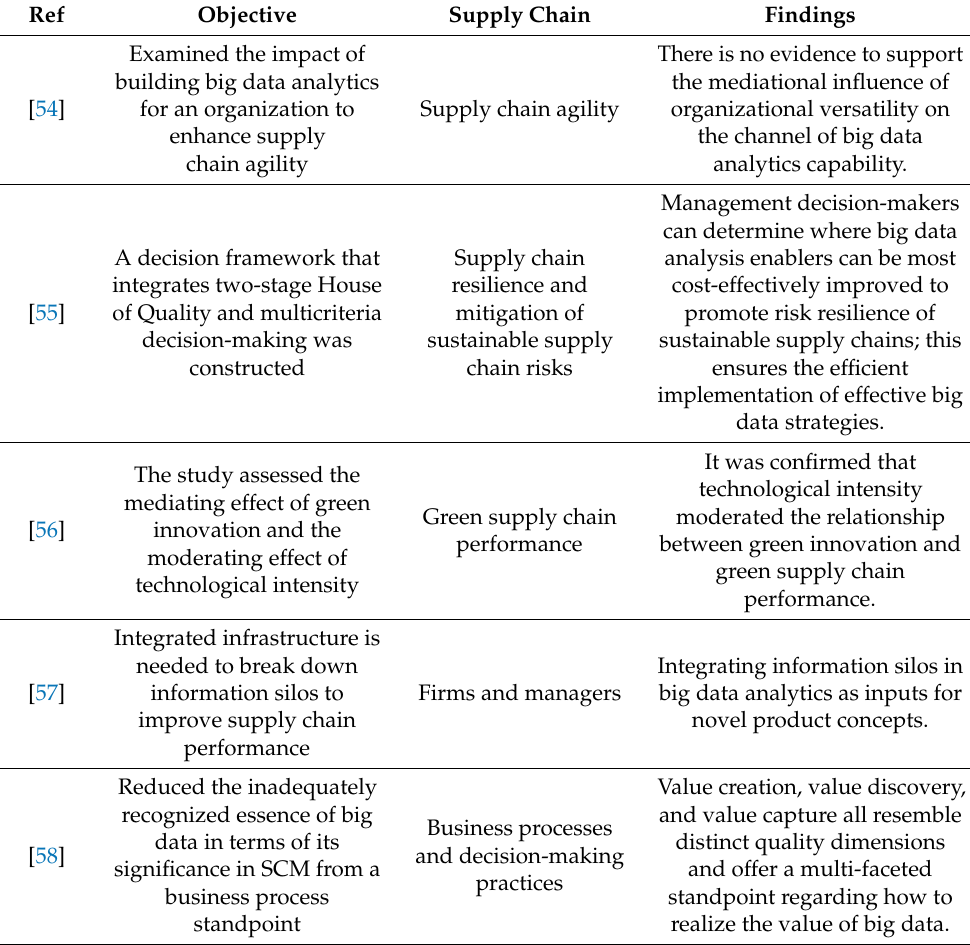
Table 2. Big data for sustainable